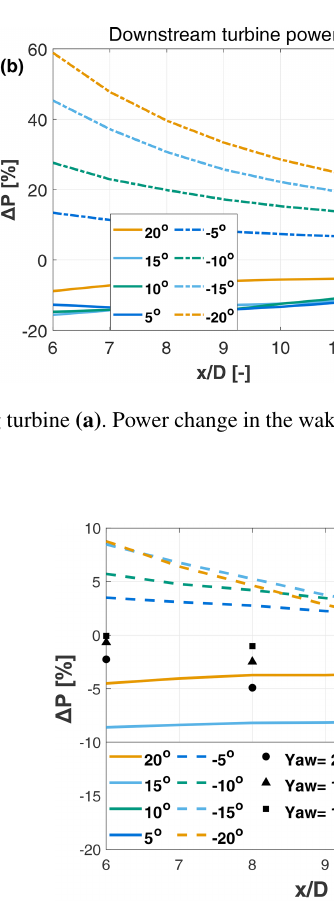
Figure 10. Cluster power change as a function of the spacing be- tween the turbines, for different tilt misalignment angles (solid and dashed lines). Black markers denote the change in cluster power for different yaw misalignment